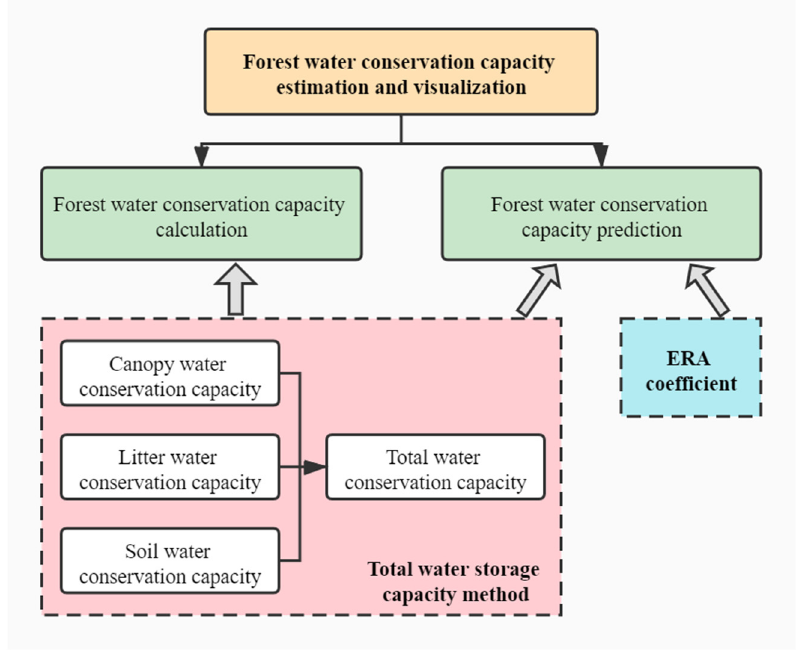
Figure 3. Assessment of water conservation function.